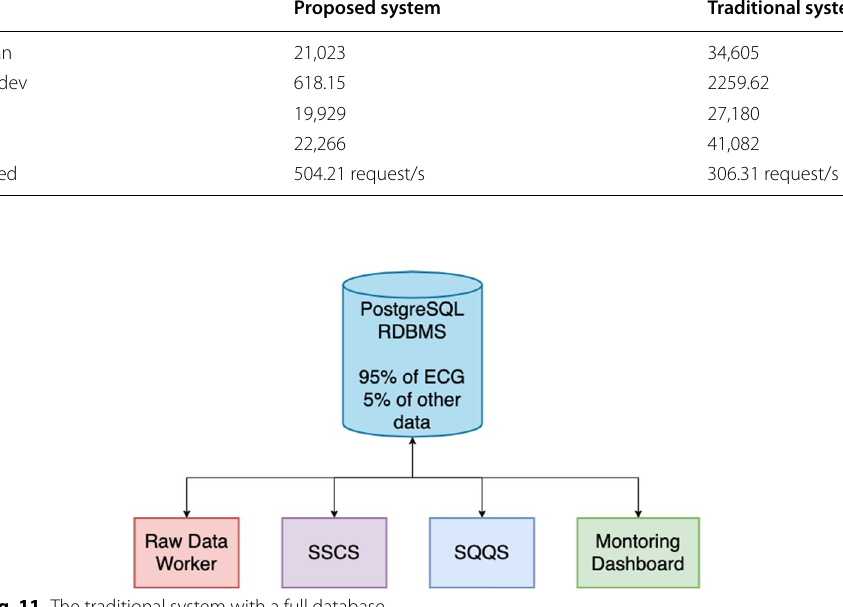
Proposed system